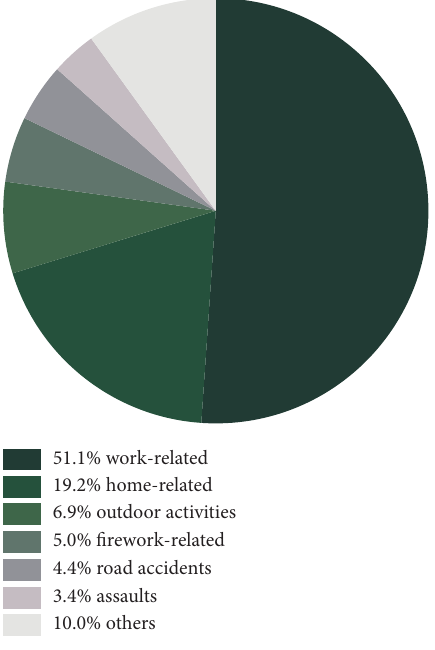
Figure 2: Causes of eye injuries.